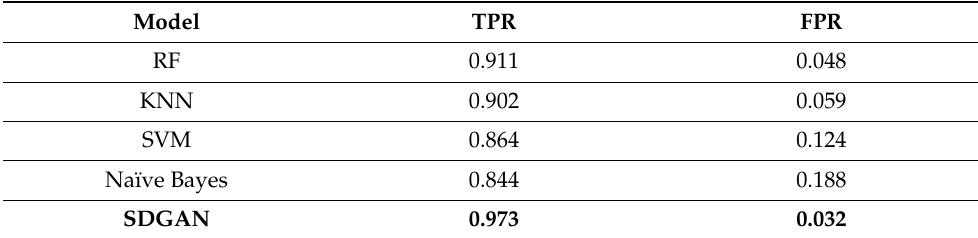
Table 4. ML-based defense DDoS detection and SDGAN on conventional NSL-KDD.